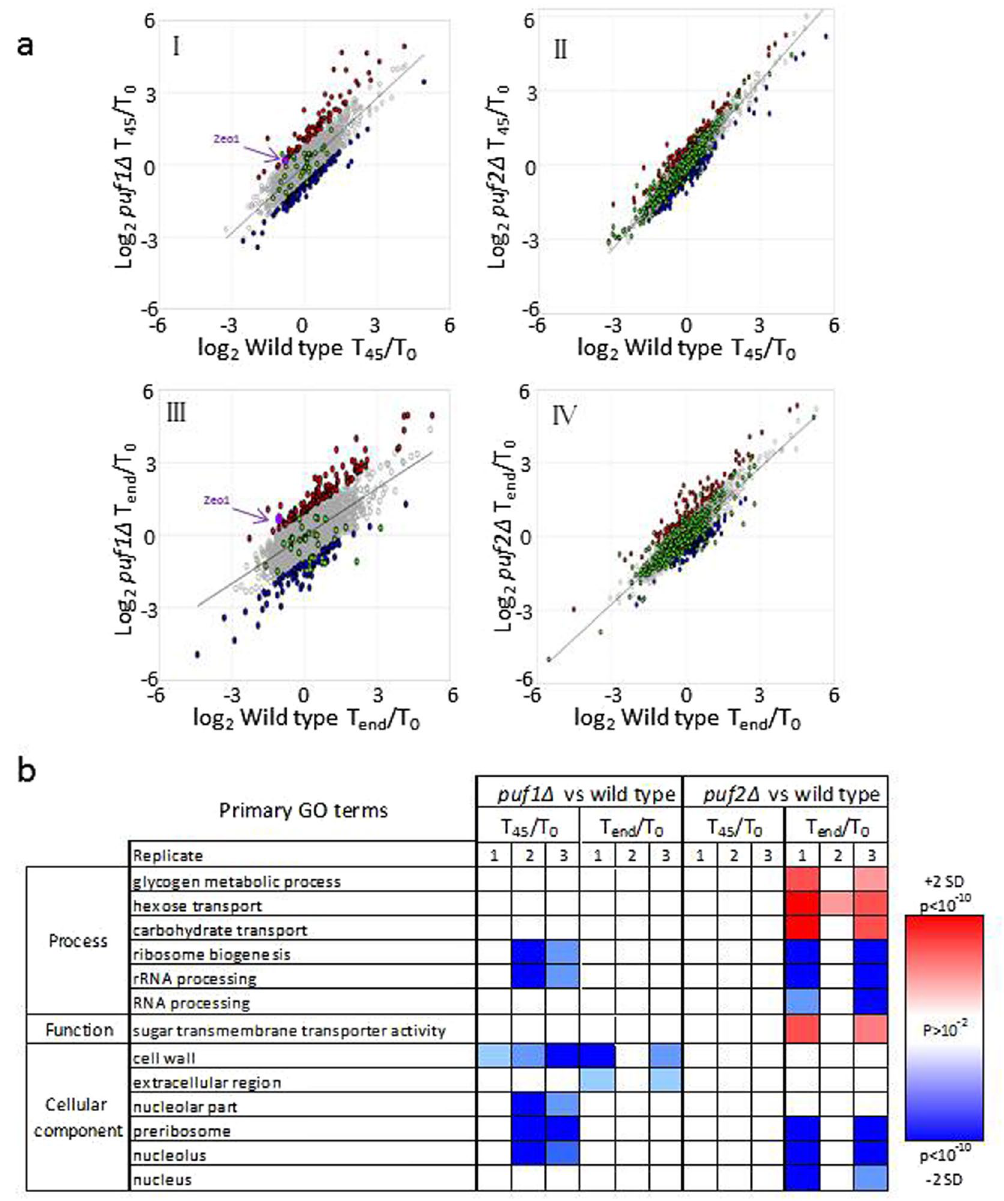
Figure 6. Distinct effects of Puf1 and Puf2 on gene expression. ( a ) Scatterplots of log 2 normalized reads of puf1 Δ (yA1382) against its isogenic wild-type (yA995) in T 45 /T 0 (I) and T end /T 0 (II), and puf2 Δ (yA637) against its isogenic wild-type (yA635) in T 45 /T 0 (III) and T end /T 0 (IV). Genes significantly affected from the knockouts are colored in red (significantly higher effect) or in blue (significantly lower effect). Genes that were previously shown to be bound by Puf1 13 or Puf2 13, 15 are indicated in green. This scatter is for one of the biological replicates, and the additional ones are shown in Supplementary Table S4. ( b ) Heatmap of SGD GO enrichment analysis of significantly affected genes in T 45 /T 0 and T end /T 0 in puf1 ∆ and puf2 ∆ relative to their isogenic wild- type strains. The red or blue shades indicate levels of enrichment score if induced or repressed, respectively. The color intensity indicates the level of p value enrichment score of each GO term. Only primary GO terms with p value < 10e − 2 and FDR < 10 − 2 were included. Full results are presented in Supplementary Table